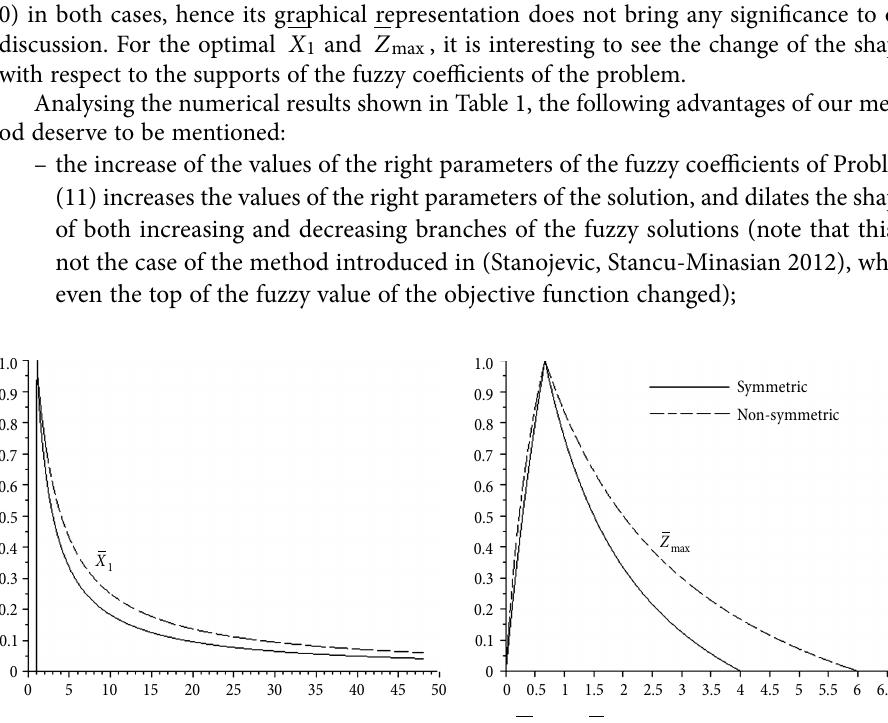
Fig. 7. The shapes of the optimal solution 1 X and max Z to Problem